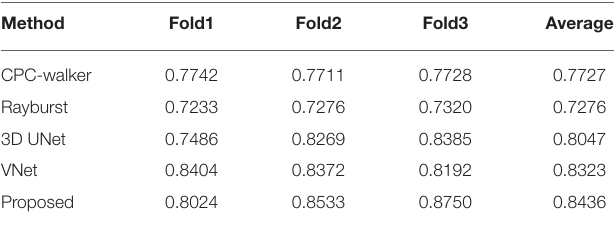
TABLE 2 | Evaluation of soma segmentation by comparing Dice